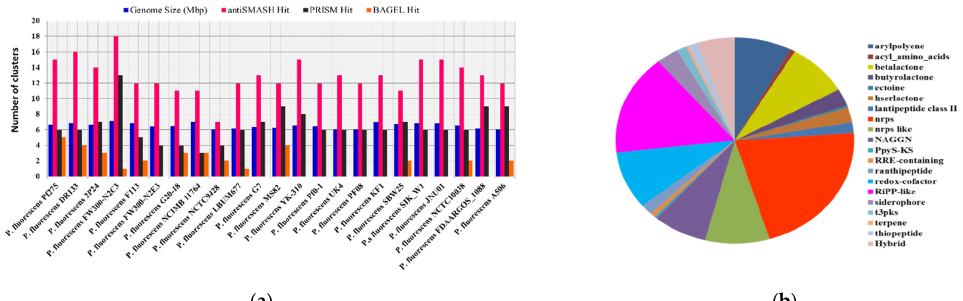
Figure 5. The correlation between genome size and the number of BGCs. ( a ) Comparative study of different genome mining hits with genome size (Mbp) in P. fluorescence subspecies and ( b ) distribution of major classes of BGCs in different P. fluorescence genomes.